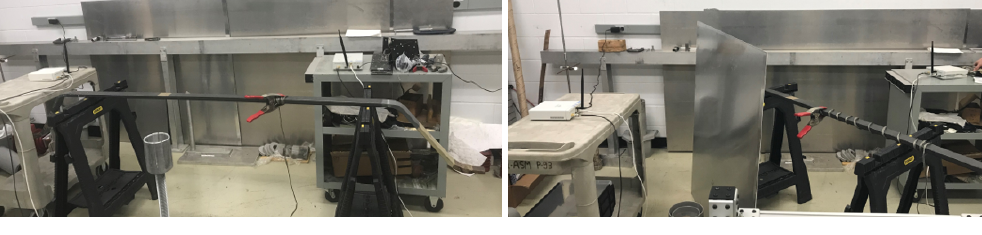
Figure 5. Measurement